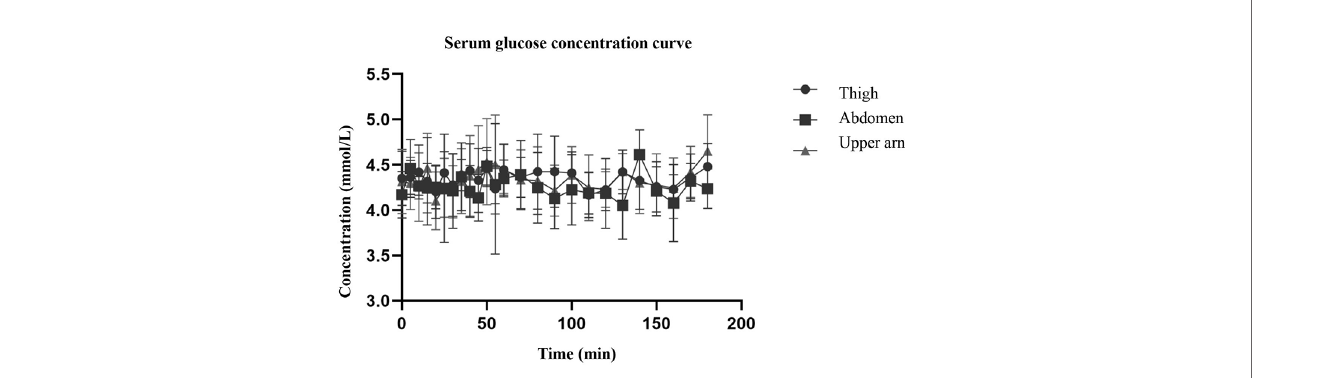
FIGURE 2 | The fi gure shows that the serum glucose concentrations of the three different injection sites were basically the same as the target blood glucose, and the blood glucose level within 3 h was basically maintained at the target blood